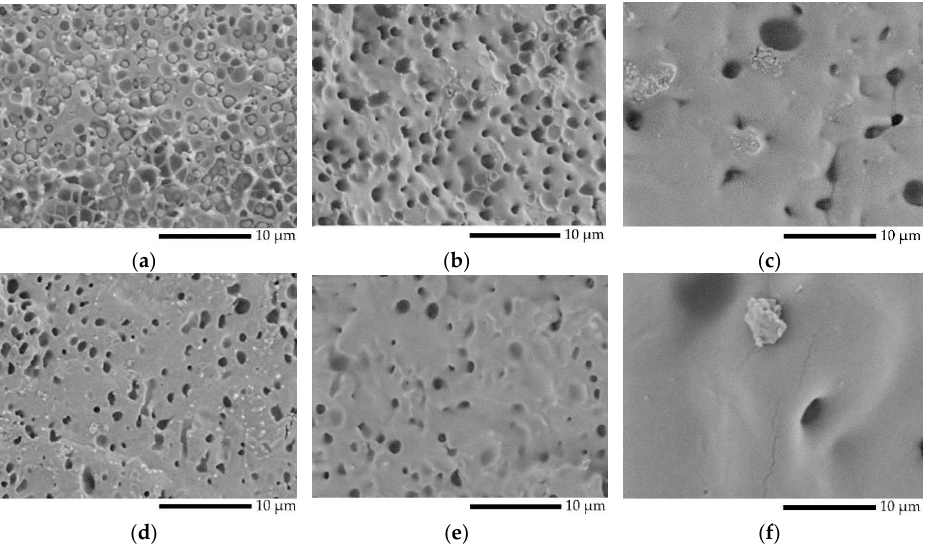
Figure 2. SEM micrographs of PLA/PVA blends at magnification of 5000x: ( a ) extruded L7V3; ( b ) extruded L6V4; ( c ) extruded L5V5; ( d ) injected L7V3; ( e ) injected L6V4; and ( f ) injected L5V5.